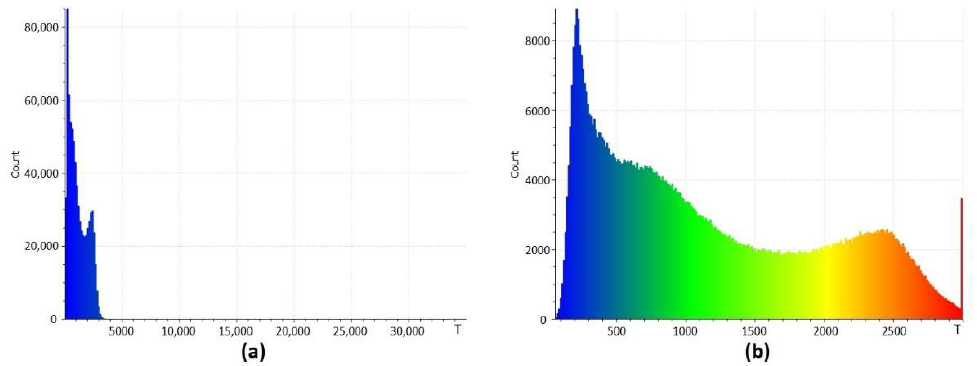
Figure 2. Histograms for the T variable ( a ) before and ( b ) after winsdorizing. In the last step, the cloud is diluted based on the distances of the neighboring points.